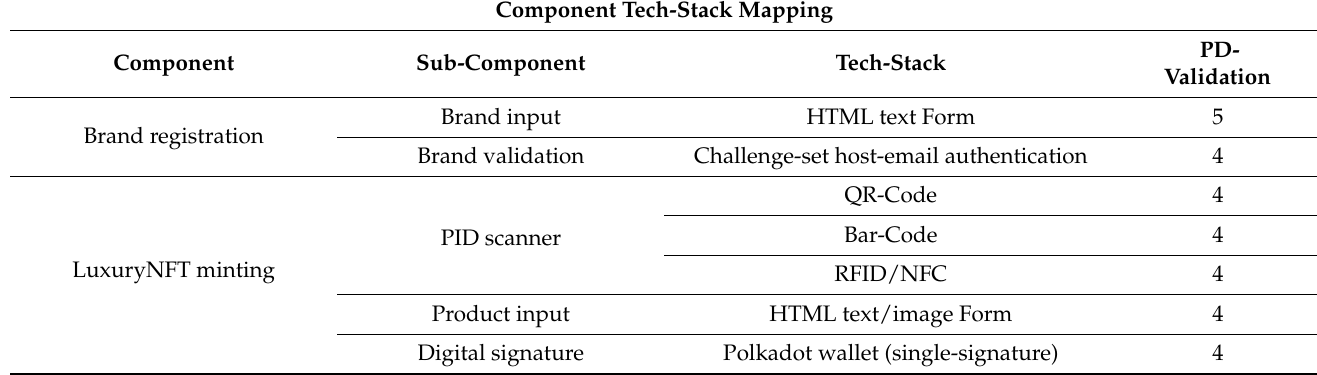
Table 2. Component tech-stack